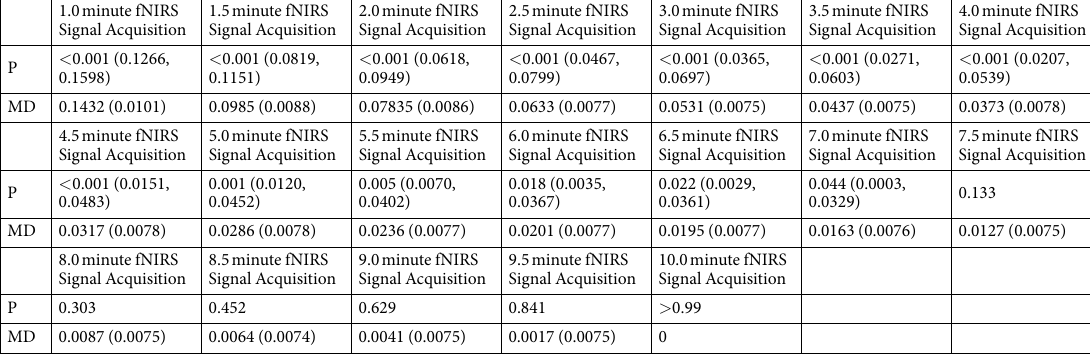
Table 1. Dunnett Post Hoc Analysis Data for Measures of Correlation Coefficient Stability Associated with fNIRS Signal Acquisition Duration. Note—Dunnett post hoc analysis data using the longest fNIRS signal acquisition duration (10.0 min) as the control group for pairwise comparisons. Data are P values (data in parentheses are 95% CIs) and Mean Difference (STD